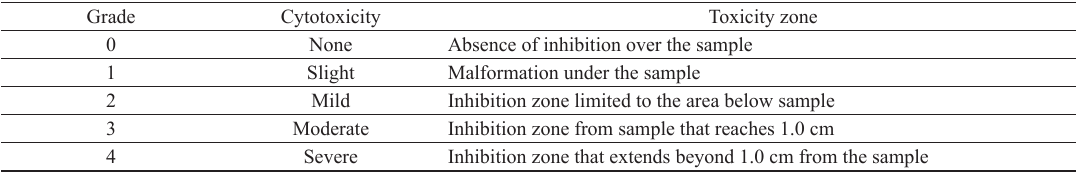
Table 2. Reactivity classification for agar diffusion test according to ISO10993-5 42 protocol.